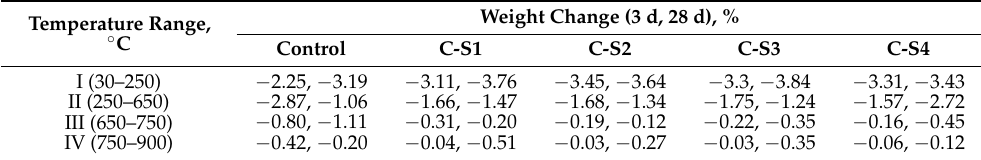
Table 4. Weight loss ratio of PCCPB with different Na 2 SO 4